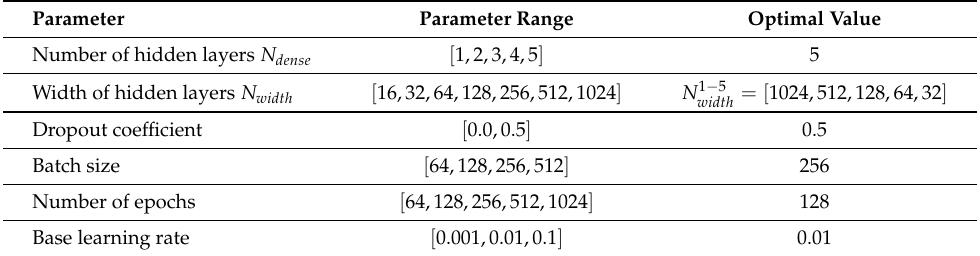
Table 4. The hyperparameters range of the DL model, and the corresponding optimal